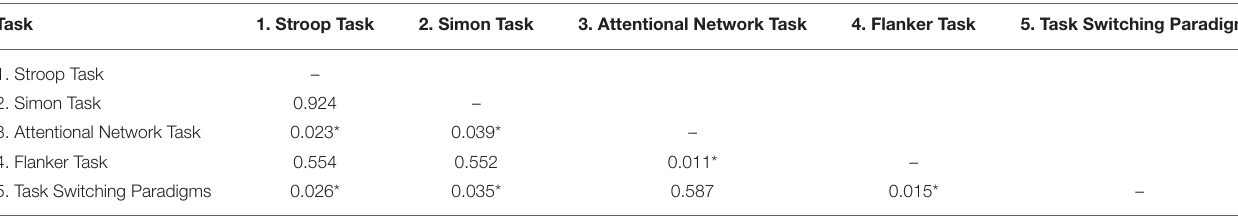
TABLE 3 | p -values from subgroup analyses comparing pairs of effect sizes from the interference effect.